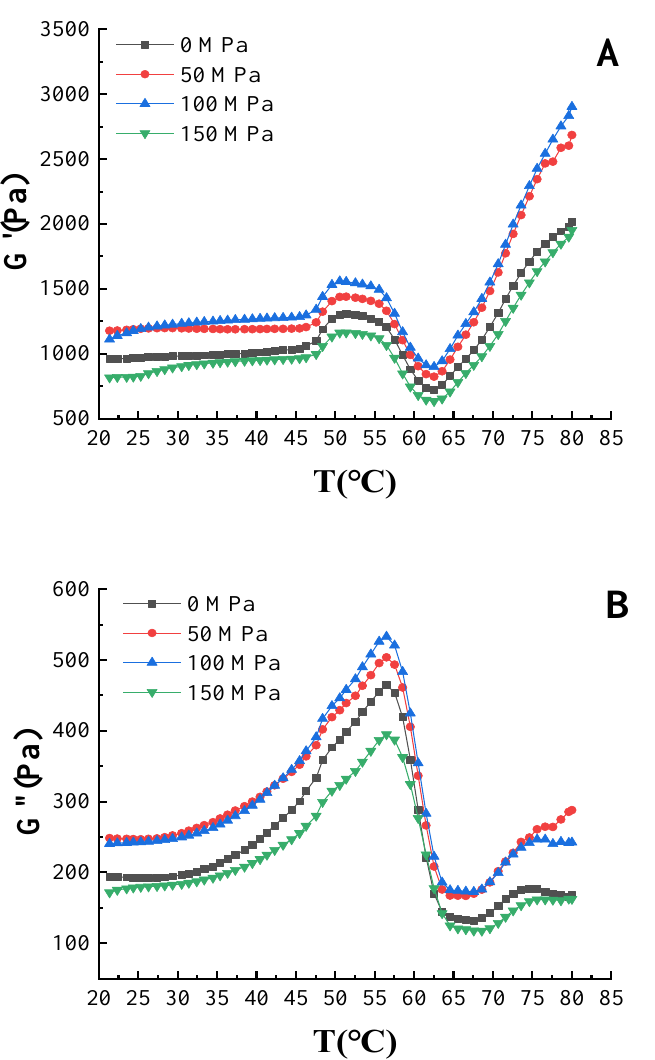
Figure 2. The storage modulus(G′) and loss modulus(G″) of pork myofibrillar protein with high-pressure homogenization-modified soy 11S globulin. ( A ): storage modulus(G′) ; ( B ): loss modulus(G″) .